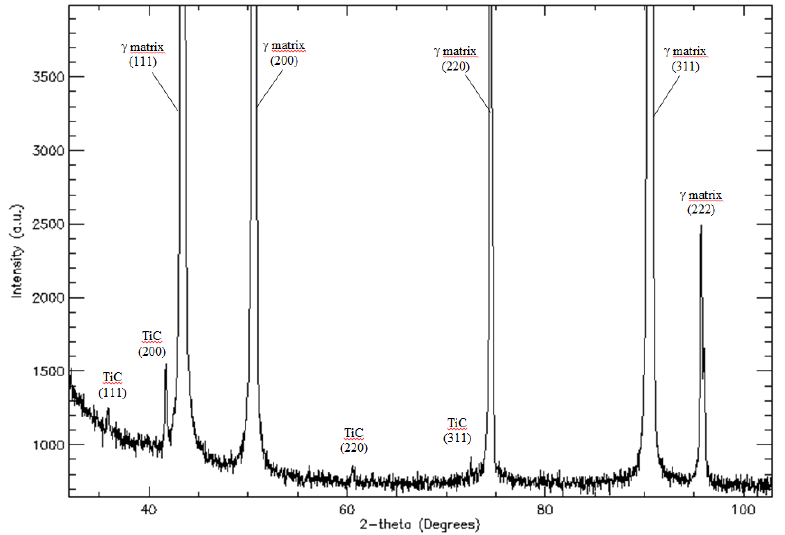
Figure 2. X-ray diffraction (XRD) patterns as obtained for the as-cast Haynes ® 282 ®